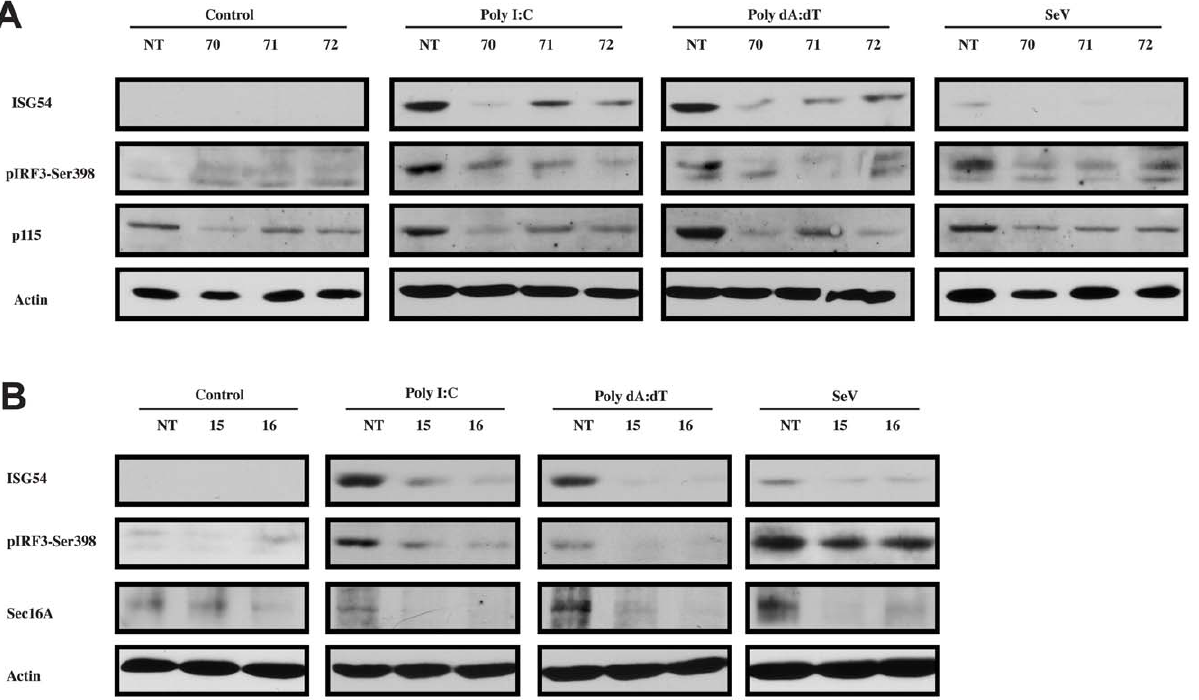
Figure 10. p115 and Sec16A are required for optimal IRF-3 activation in response to activation of cytosolic RNA and DNA sensors. HeLa cells were infected with lentiviral vectors encoding shRNA targeting p115 ( A ) or Sec16A ( B ) and non-targeting (NT) control shRNA for 24 h followed by puromycin selection (1.5 m g/ml) for 5 days. Cells were left untreated or stimulated with poly I:C (1 m g/ml), poly dA:dT (1 m g/ml) or SeV (200 HAU/ml) for 16 h. Whole-cell lysates were prepared and subjected to immunoblot analysis with indicated antibodies. One of two independent experiments with similar results is shown.